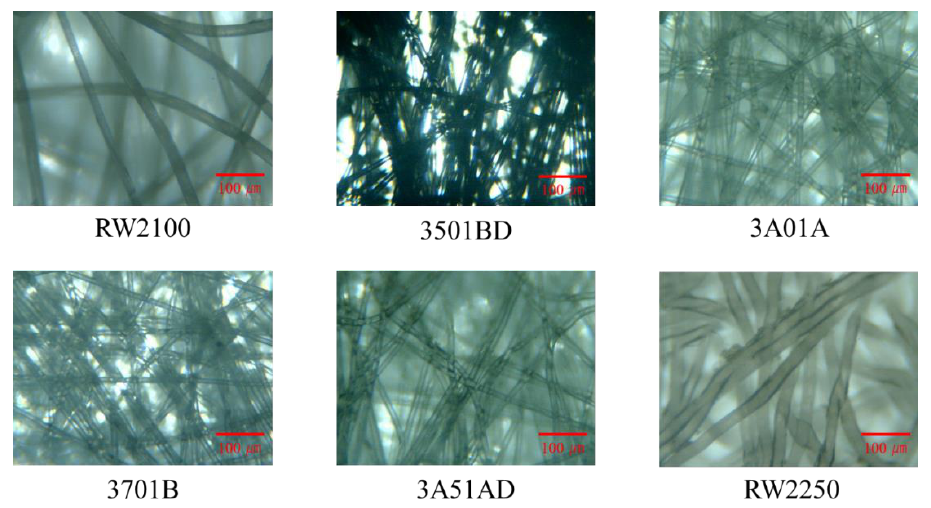
Figure 2. Microphotographs of nonwoven fabric sheets.